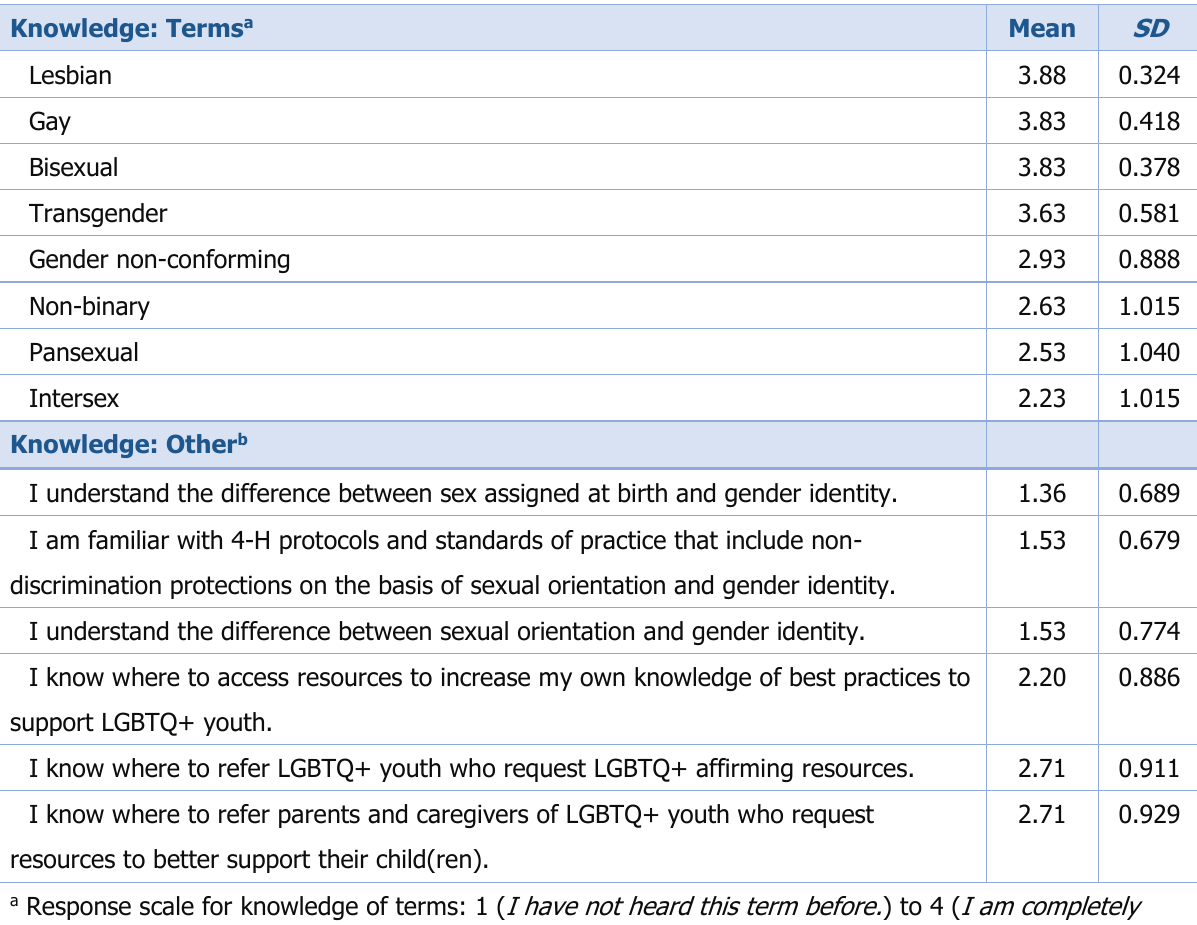
Table 2. Means and Standard Deviations for Respondents’ Reported Knowledge